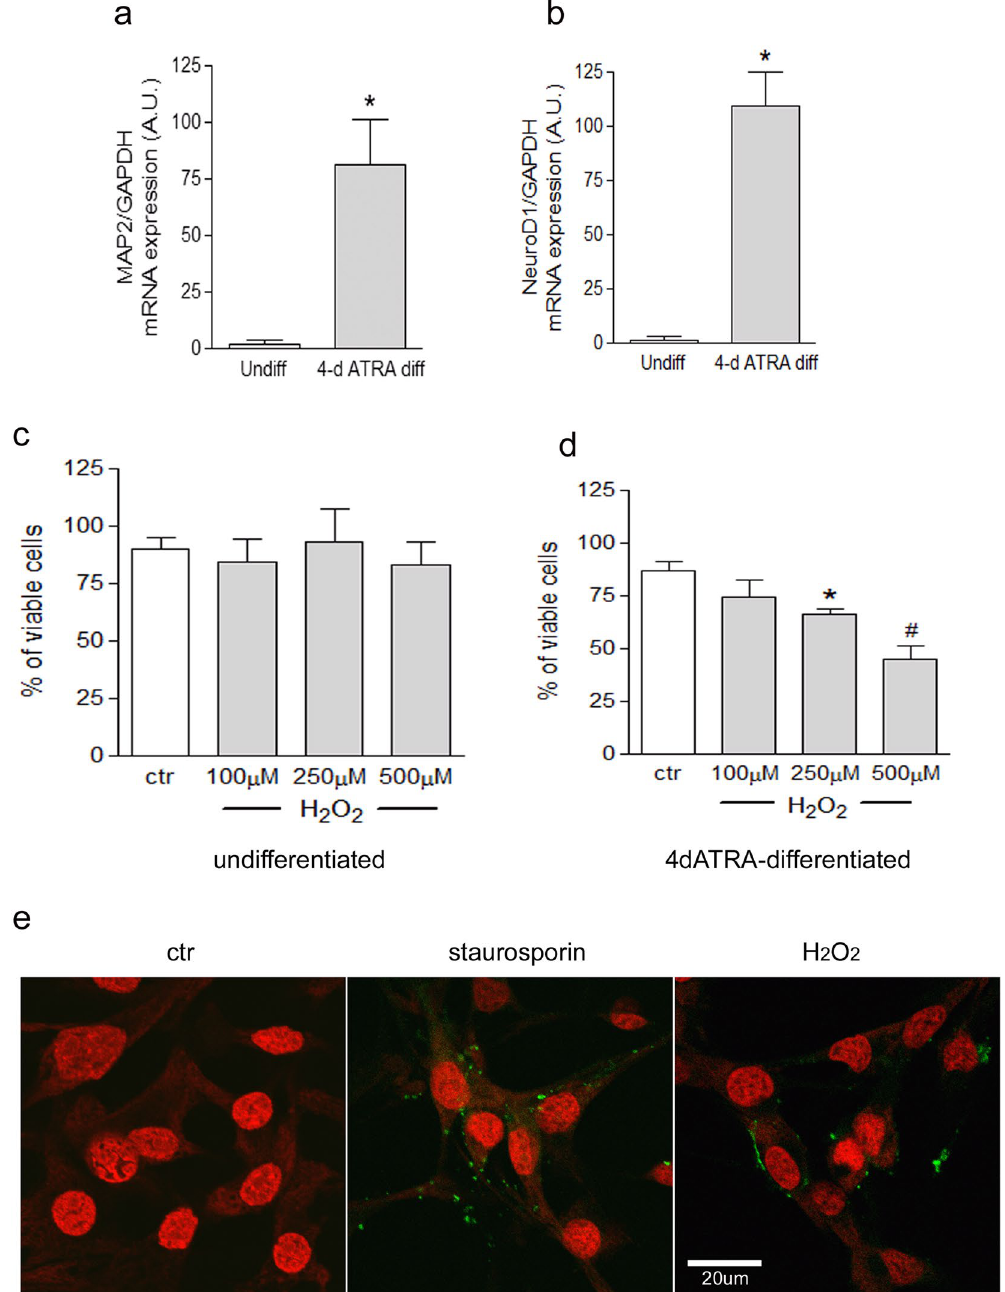
Figure 1. ATRA-induced differentiation increases sensitivity to H 2 O 2 , favoring the onset of apoptosis. ( a and b ) Cell differentiation is checked by RT-PCR analysis of MAP2 and NeuroD1. Statistical analysis: n = 3, * p < 0.05 vs undiff. ( c and d ) The number of viable cells have been analyzed by using Trypan blue dye after 24 h exposure to H 2 O 2 and expressed as a percentage of viable cells. Statistical analysis: n = 4, * p < 0.05 and # p < 0.01 vs control cells. ( e ) Positivity to Annexin V-FITC (green staining) of 4d-ATRA differentiated cells has been checked as a marker of early apoptosis after 24 h treatment with 500 µ M H 2 O 2 and appears as a spotted green membrane fluorescence. Treatment with 100 nM staurosporin has been used as positive control. Nuclei are counterstained by To-Pro3 iodide as detailed in Materials and Methods. Scale bar = 20 µ